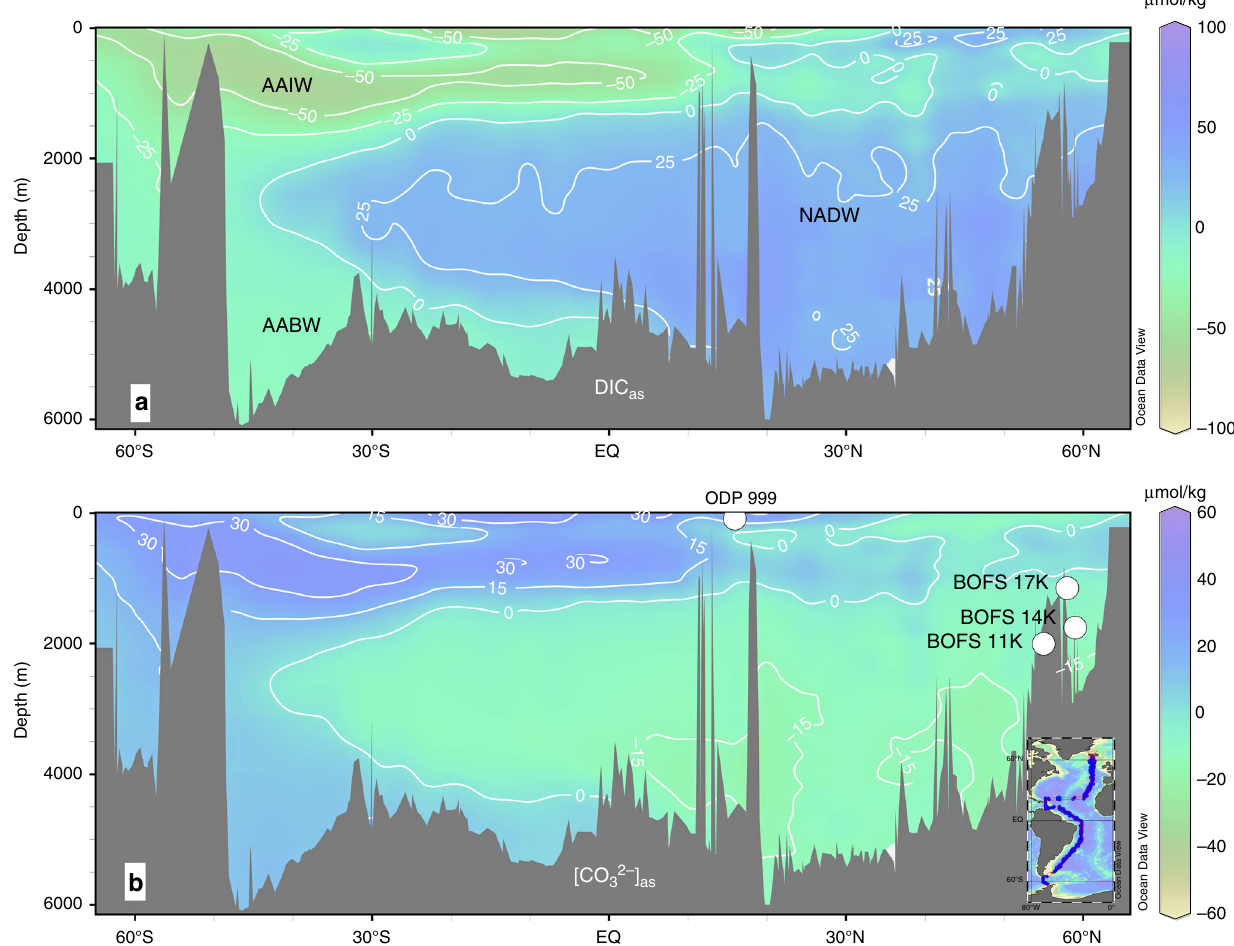
Fig. 2 Preindustrial Atlantic air – sea exchange tracers. a DIC as . b [CO 3 2 − ] as . Circles represent studied sediment cores. Inset: GLODAP hydrographic data 2 used to generate the sections 96 . NADW North Atlantic deep water, AABW Antarctic bottom water, AAIW Antarctic intermediate water. See Methods